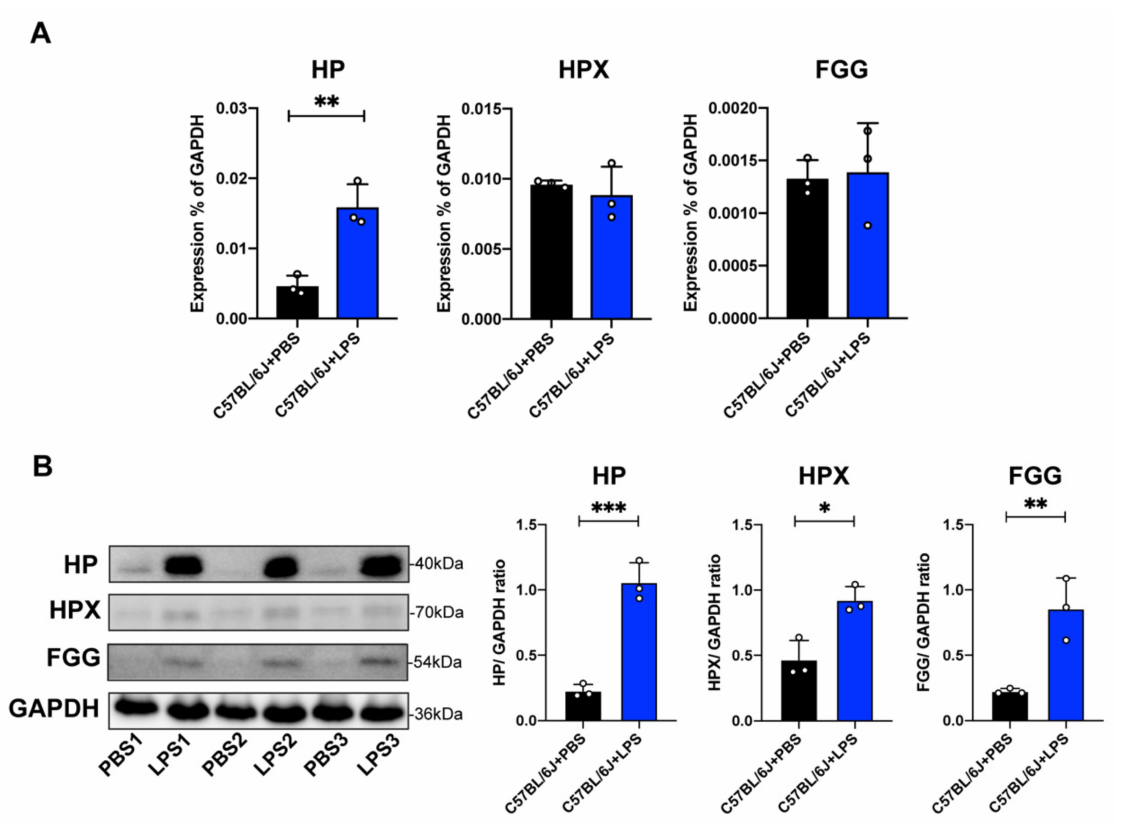
Figure 6. ( A ) The mRNA expression levels of haptoglobin (HP), hemopexin (HPX), and fibrinogen gamma chain (FGG) in the retina of C57BL/6J mice treated by LPS (n = 3) or PBS (n = 3). ( B ) The protein expression levels of retinal HP, HPX, and FGG in LPS-treated C57BL/6J mice (n = 3) or PBS-treated C57BL/6J control groups (n = 3) were measured by Western blot analysis. GAPDH levels were used as a loading control. Representative Western blot images were shown on the left, and quantification of protein levels (right panel) were normalized to GAPDH protein levels. Data are expressed as the mean ± SD. * p < 0.05, ** p < 0.01, *** p <